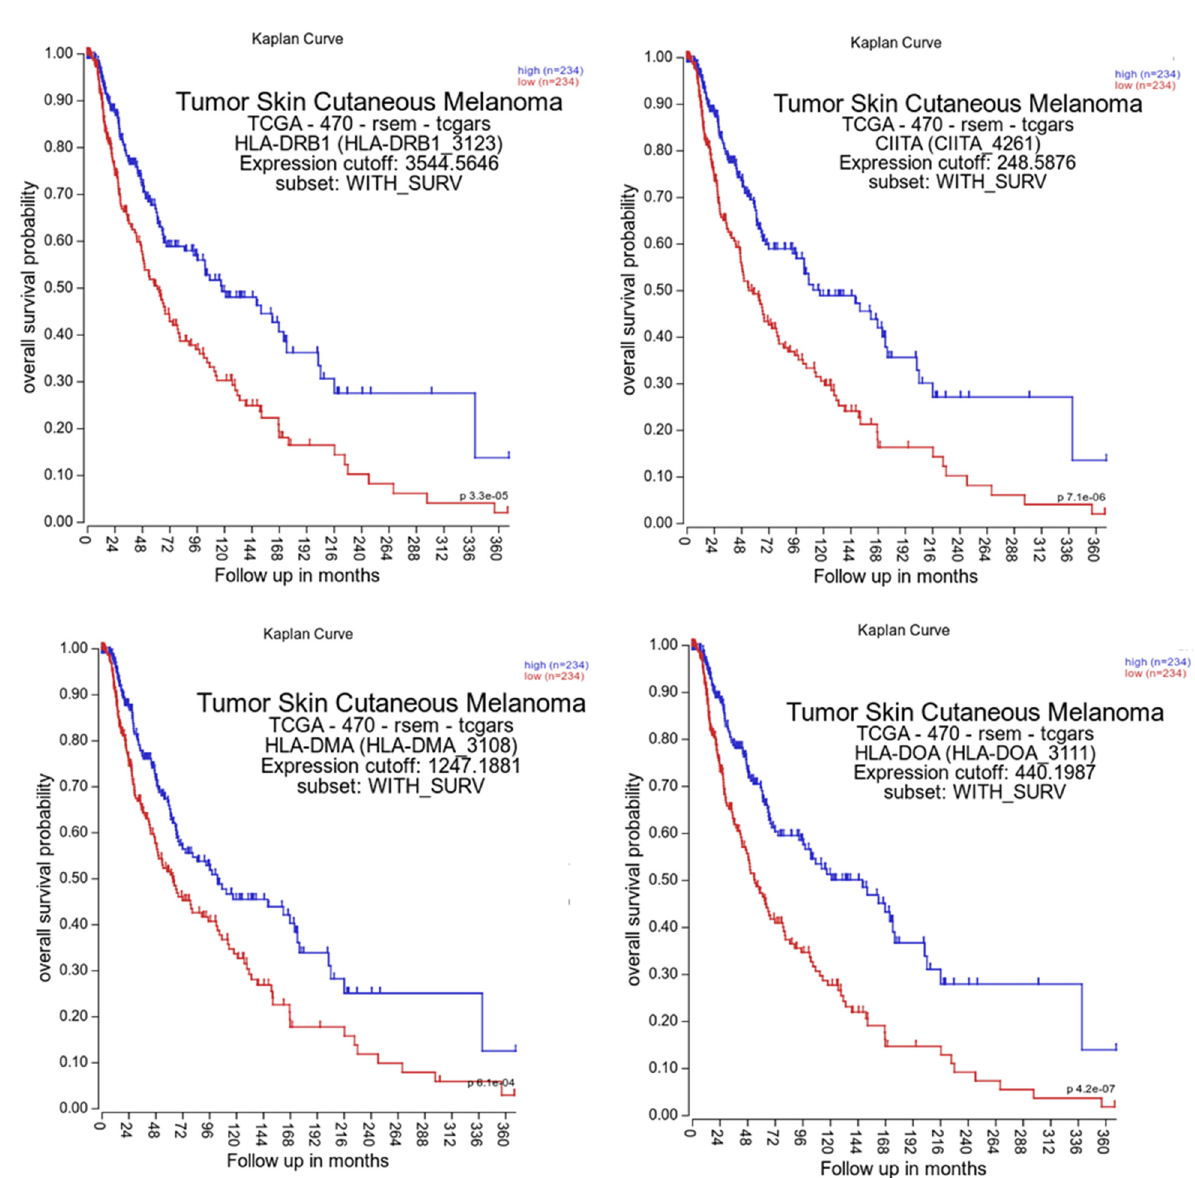
Figure 6. Correlation of HLA class II APM expression with the survival of melanoma patients, using TCGA data. For analysis of the OS of melanoma patients, the TCGA data were analyzed as described in Material and Methods.